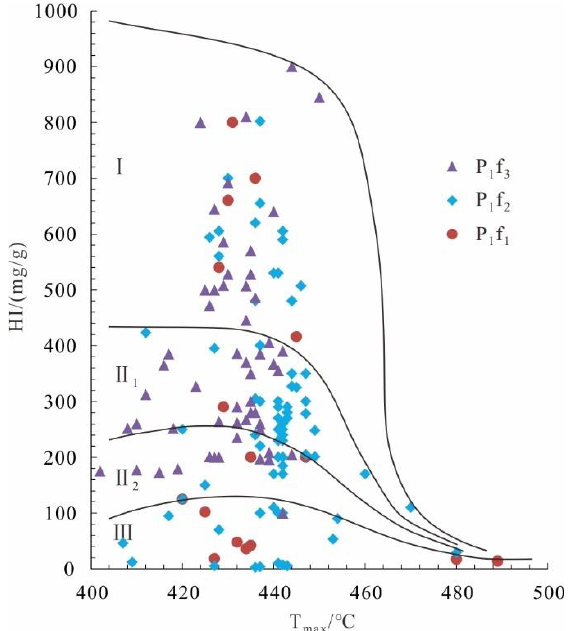
Figure 7. Scatter plot of T max versus HI of different members in the Fengcheng Formation of Mahu Sag.